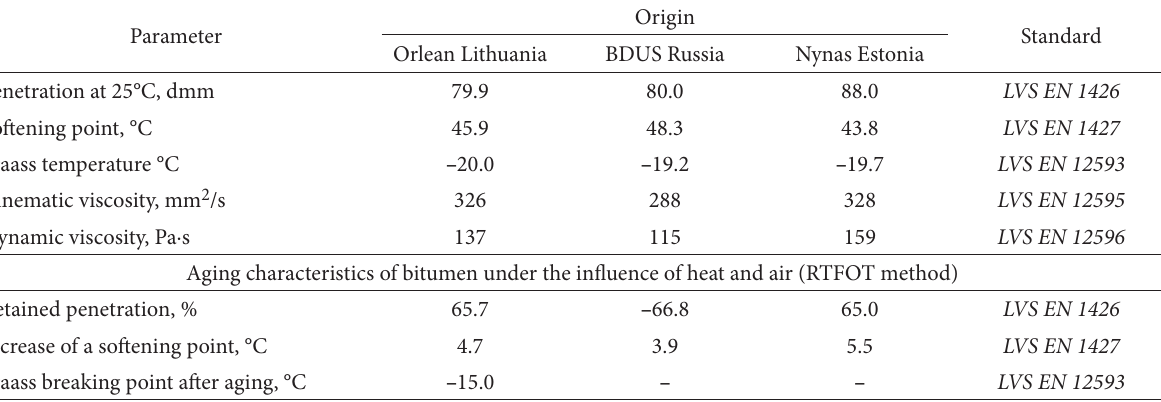
Table 2. Typical characteristics of the bitumens